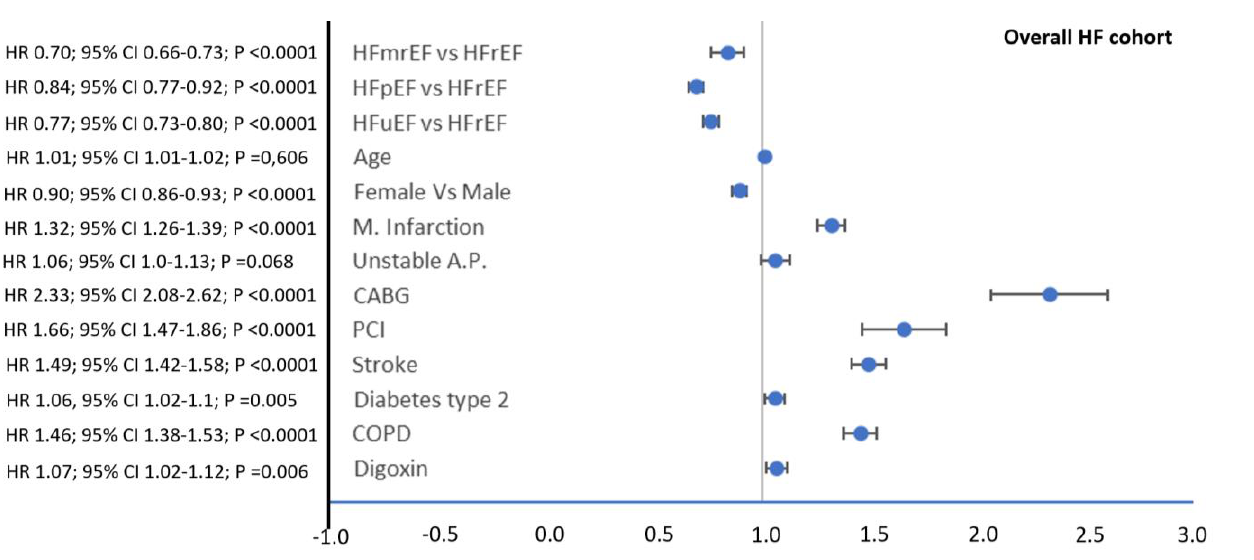
Figure 1. Survival free of adverse clinical outcomes. ( a ) Survival free of the composite MACE out- come: overall and by EF subgroup. ( b ) Survival free of stroke: overall and by EF subgroup. ( c ) Sur- vival free of all-cause mortality: overall and by EF subgroup. ( d ) Survival free of myocardial infarc- tion: overall and by EF subgroup. ( e ) Survival free of HF hospitalization: overall and by EF sub- group. ( f ) Survival free of HF hospitalization and all-cause mortality: overall and by EF subgroup. Abbreviations: EF = ejection fraction; HF = heart failure; HFmrEF = heart failure with a mildly re-